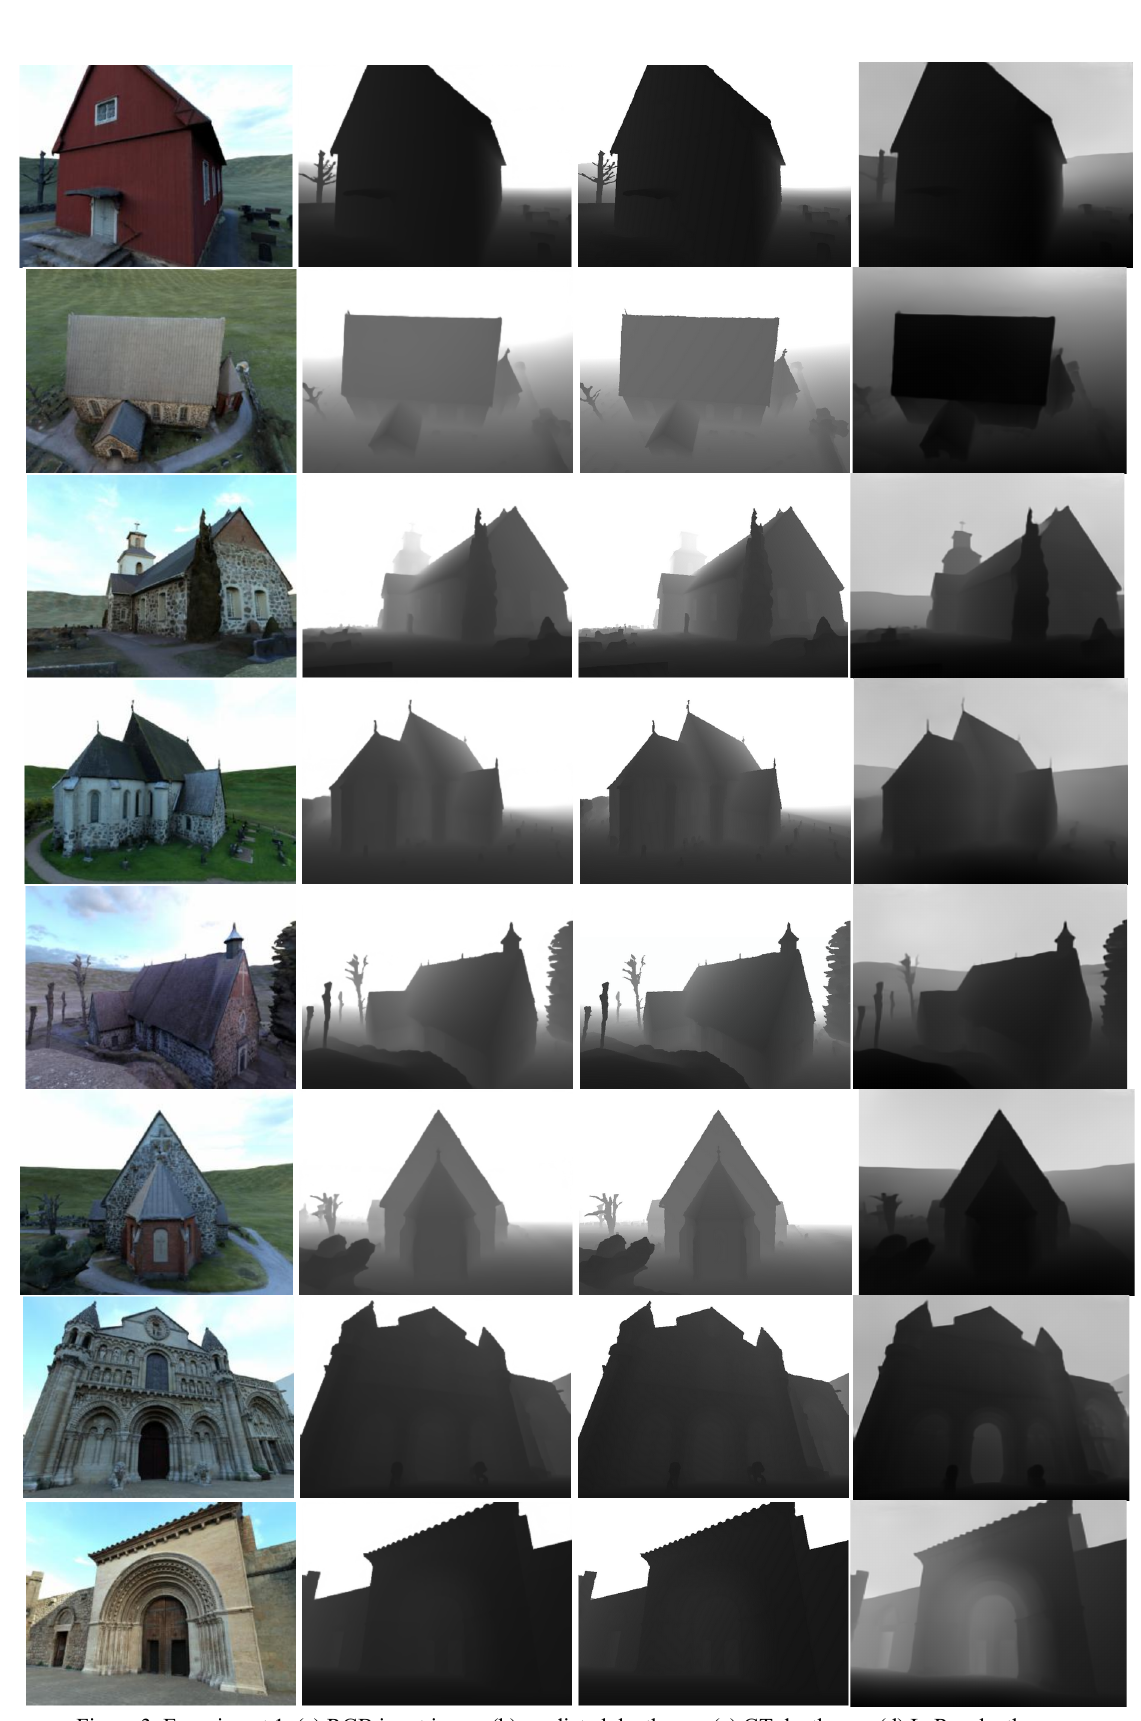
Figure 3. Experiment 1. (a) RGB input image (b) predicted depth map (c) GT depth map (d) LeRes depth